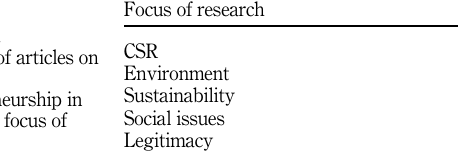
Focus of research